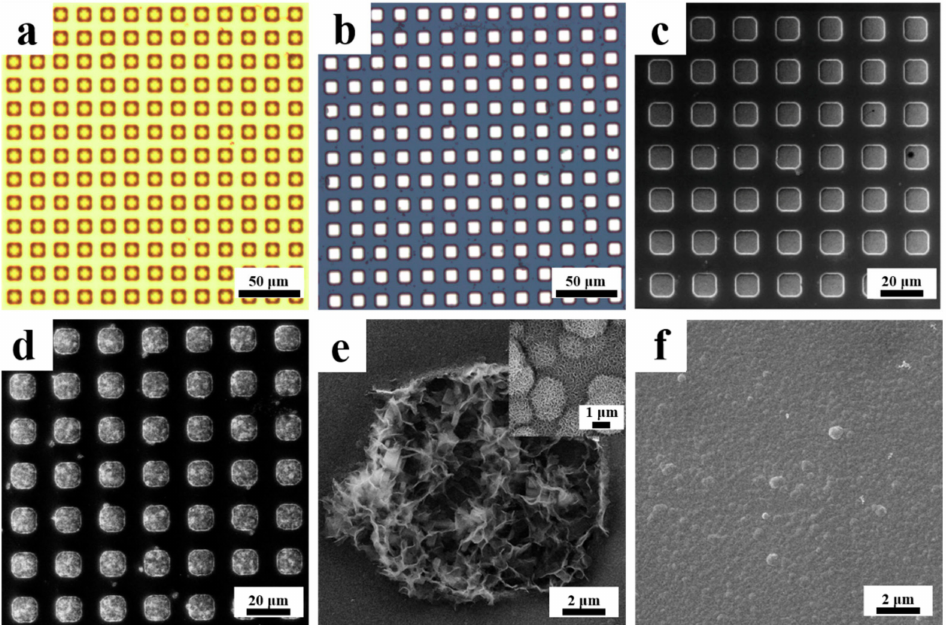
Figure 2. Metallographic microscope image of micropatterned photoresist ( a ) and micropatterned PPy ( b ); SEM image of micropatterned PPy ( c ), micropatterned PPy/HA composite coatings ( d ), local enlarged SEM images of HA ( e ) and PPy ( f ) morphologies in micropatterned PPy/HA compos- ite